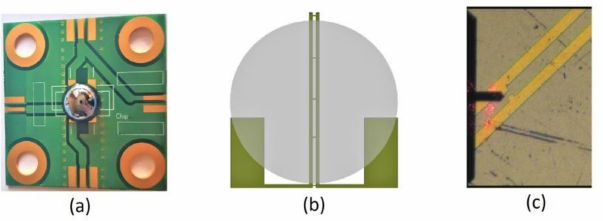
Figure 2. A ( a ) photo of the circuit board assembly; ( b ) sketch of the electrodes, with the gray circle representing the projection of the silicon lens onto the plane of the electrodes; and ( c ) image of the inter-electrode gap under a microscope. The gap width is 20 µ